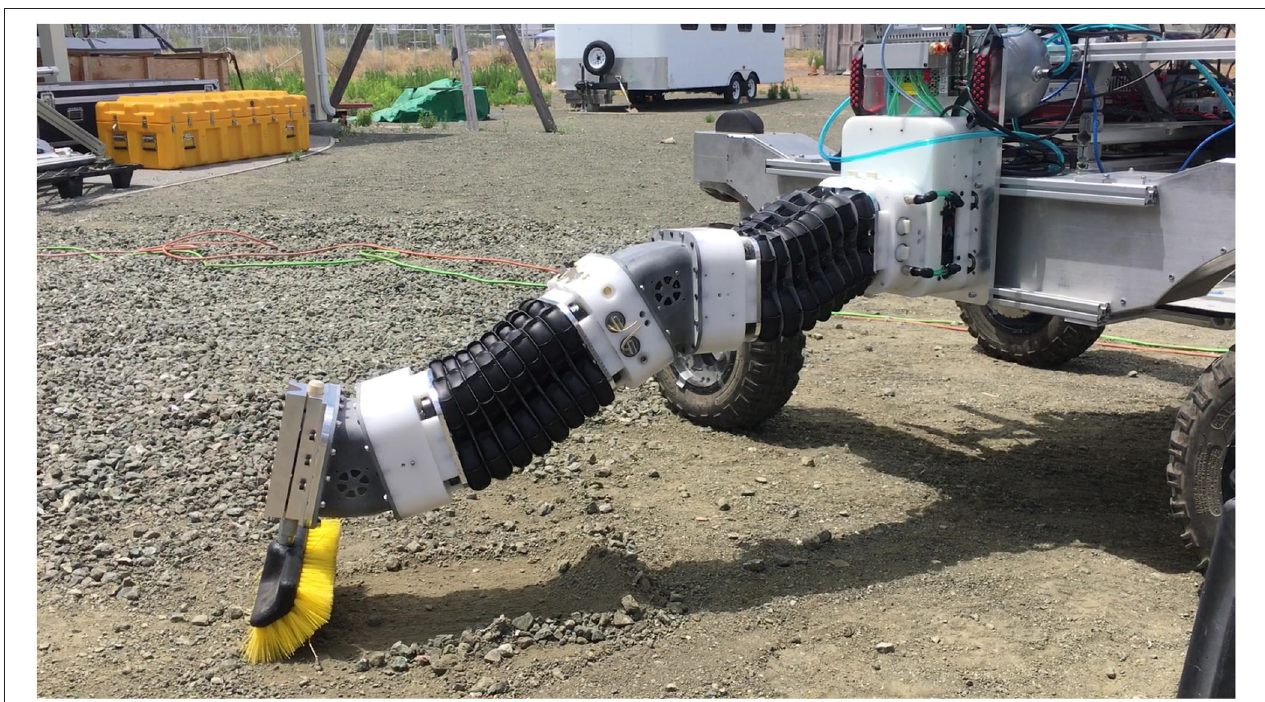
FIGURE 1 | A compliant continuum robot exhibiting non-constant curvature bending in its joints (especially in the first joint) when under load while performing a real-world task.